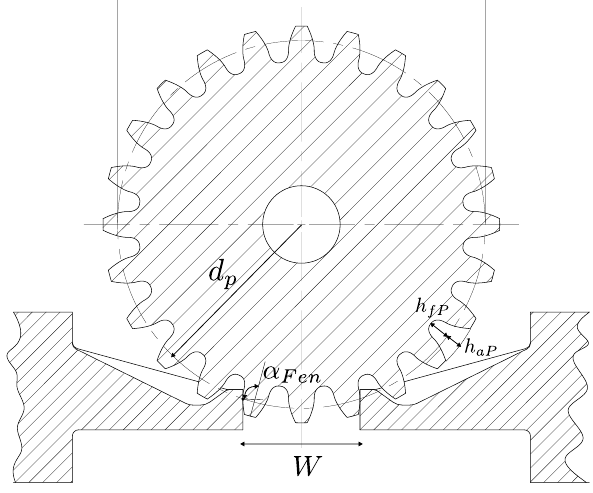
Figure 4. STBF test